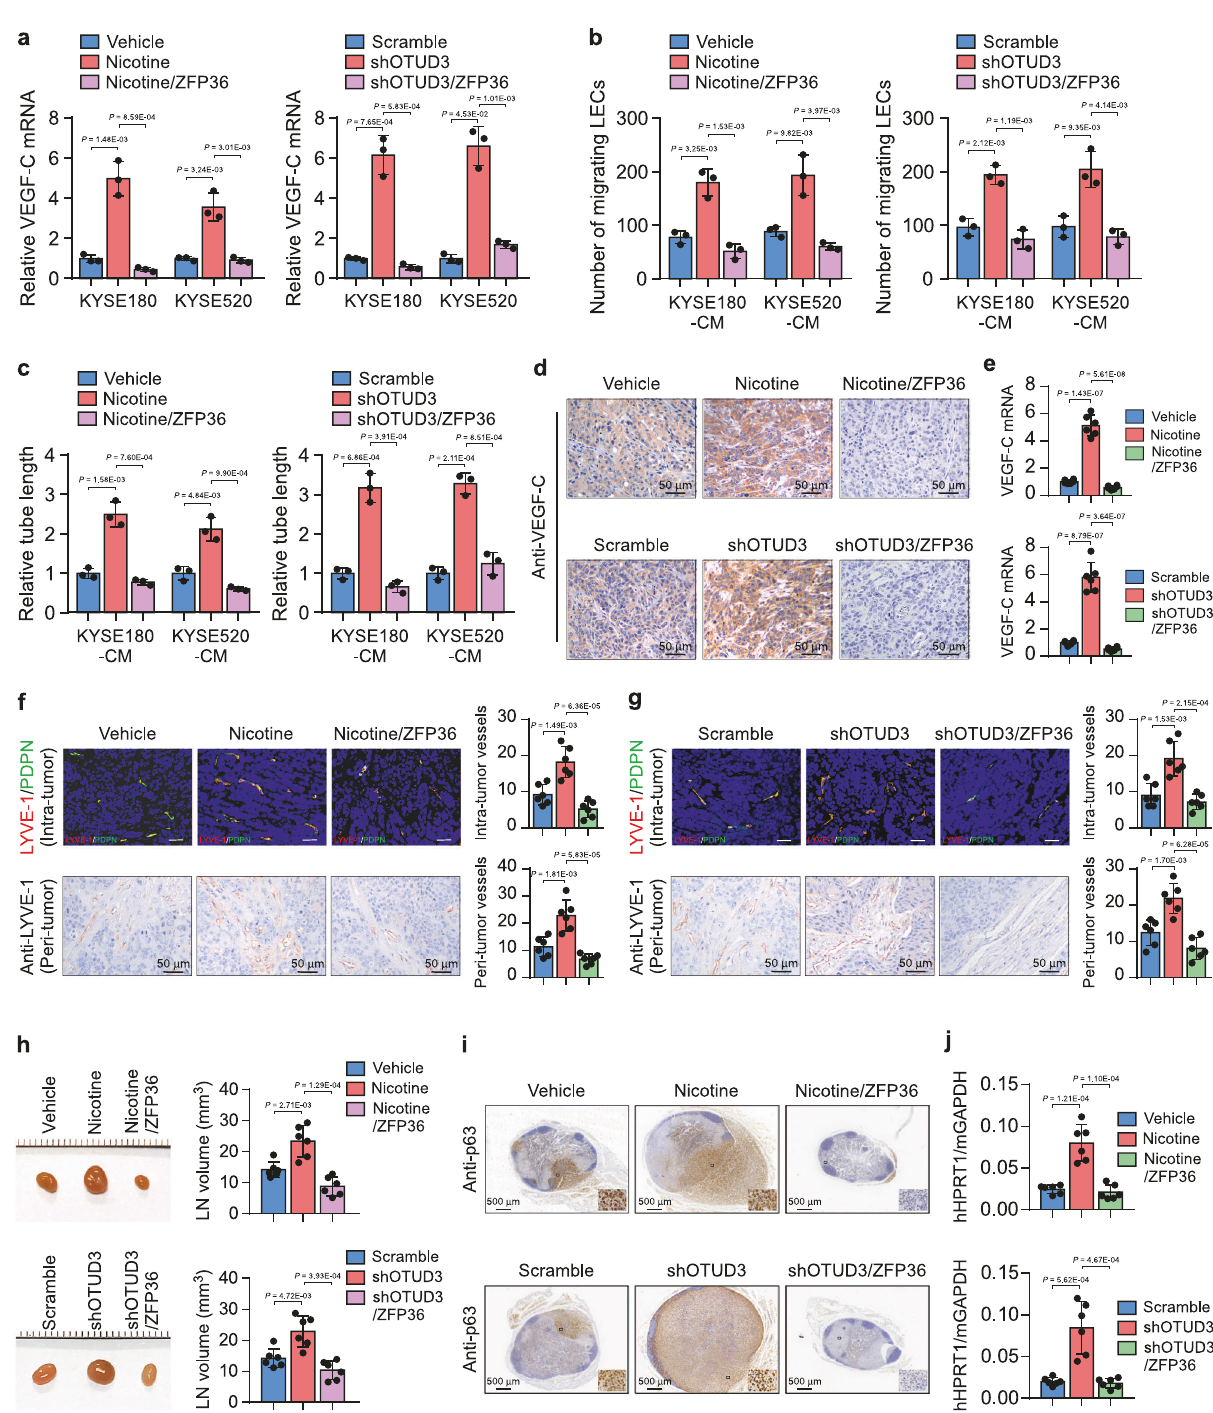
Fig. 6 Induction of VEGF-C mRNA decay abrogates lymphatic metastasis. a qRT-PCR analysis of VEGF-C mRNA expression in the indicated esophageal cancer cells. b Quanti fi cation of migrating LECs incubated with the indicated CM. c Relative tube length of LECs under treatment of the indicated CM. d The role of ZFP36 in the inhibition of lymphatic metastasis was examined by the inguinal lymph node metastasis model. Shown are the representative IHC staining of VEGF-C in footpad tumors from each group ( n = 6). Scale bars: 50 µ m. e qRT-PCR analysis of VEGF-C mRNA expression in the indicated footpad tumors ( n = 6/group). f , g Representative images and quanti fi cation of intra-tumoral and peri-tumoral lymphatic vessels in footpad tumors as indicated by dual-IF of LYVE-1 and PDPN and IHC staining of LYVE-1. Scale bars: 50 µ m. h Representative image of inguinal LNs. The volumes of LNs from each group were quanti fi ed. i Representative IHC staining images of squamous cell carcinoma marker p63 in LNs. The p63-positive cells indicated the metastatic KYSE180 cells in LNs and were enlarged in the insets. Scale bars: 500 µ m. j qRT-PCR analysis of human HPRT1 relative to mouse GAPDH in the LNs from each group. The ratio indicated the proportion of metastatic cells. Each error bar in a – c represents the mean ± SD of three biological replicates. Data in e – h , j represent the mean ± SD derived from tumor mouse models ( n = 6 mice/group). Two-sided Student ’ s t test was used for all panels. Source data are provided as a Source data fi